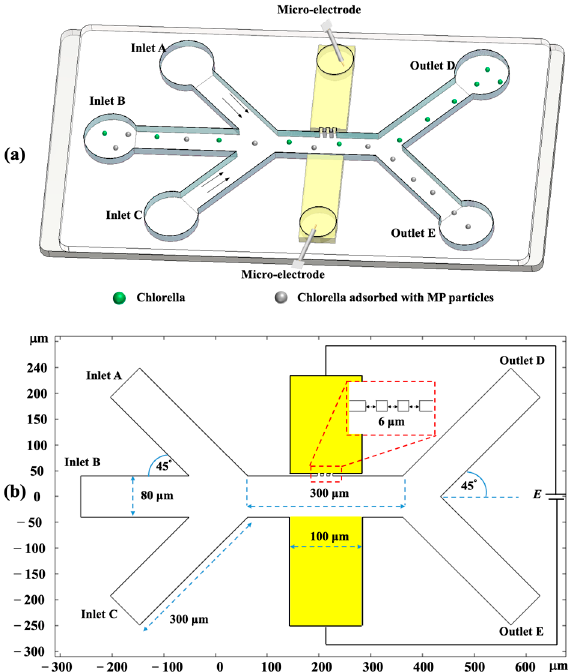
Figure 2. Schematic illustration of ( a ) side view and ( b ) top view of the asymmetric-orifice-based DC–DEP microfluidic chip with triple-pairs-of-orifices